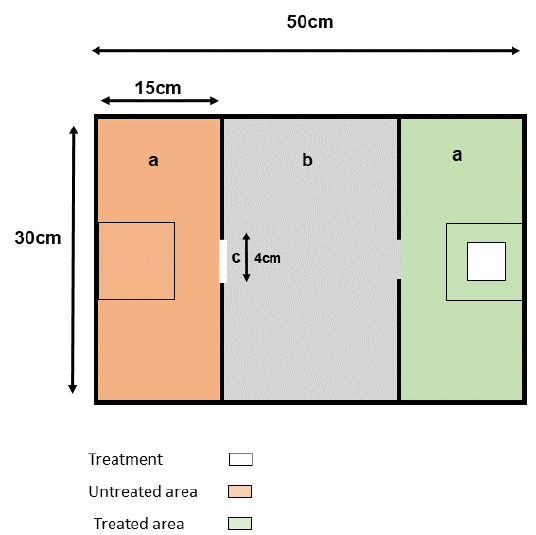
Figure 1. Top view schema of the device used for the behavioural tests. ( a ) Lateral areas where the treatment was randomly applied to one of the two sides; ( b ) central area where animals were released; ( c ) opening between the lateral and central areas.